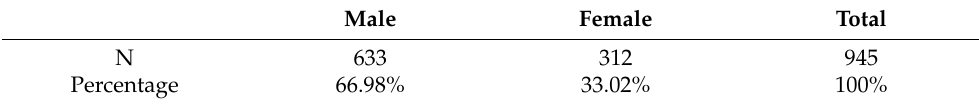
Table 1. Participants are distributed according to their gender. Male Female Total N 633 312 945